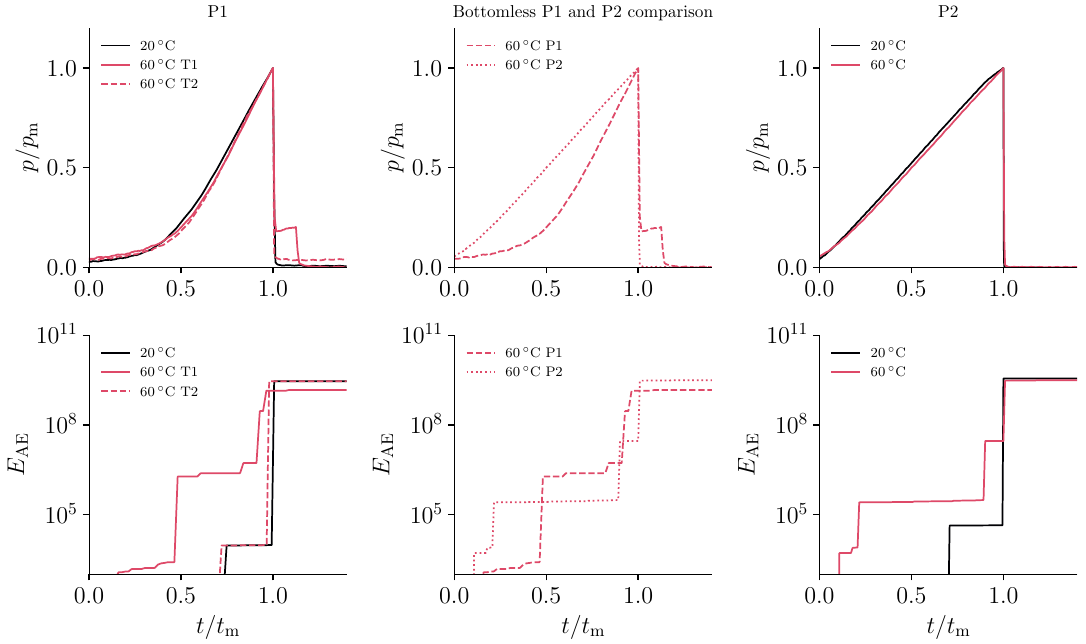
Figure 6. Normalized pressure p / p m and cumulative acoustic emission energy E AE for all tests carried out in the glassy regime of PMMA. The normalized pressure-time curves are self similar, while the AE energy signature proves that higher temperature and a loading path that promotes deviatoric stress concentration can result in earlier onset of inelastic processes during